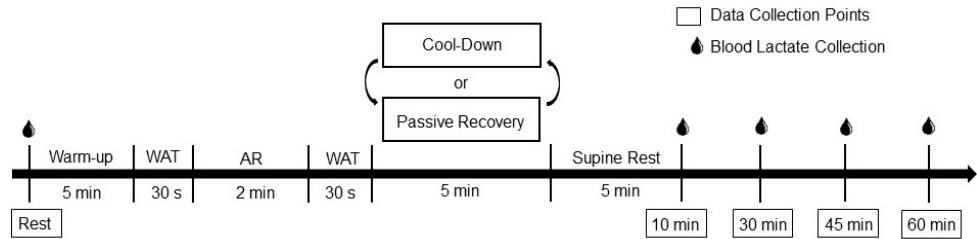
Figure 1. Experimental trial timeline. WAT = Wingate anaerobic test. AR = active recovery.